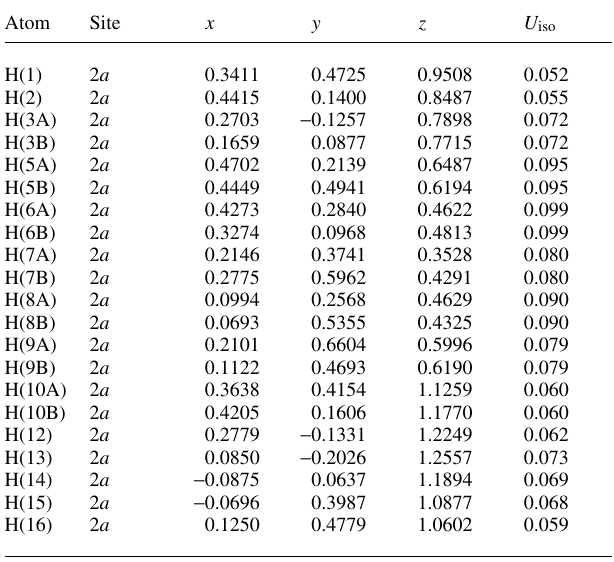
Table 2. Atomic coordinates and displacement parameters (in Å 2 ) .